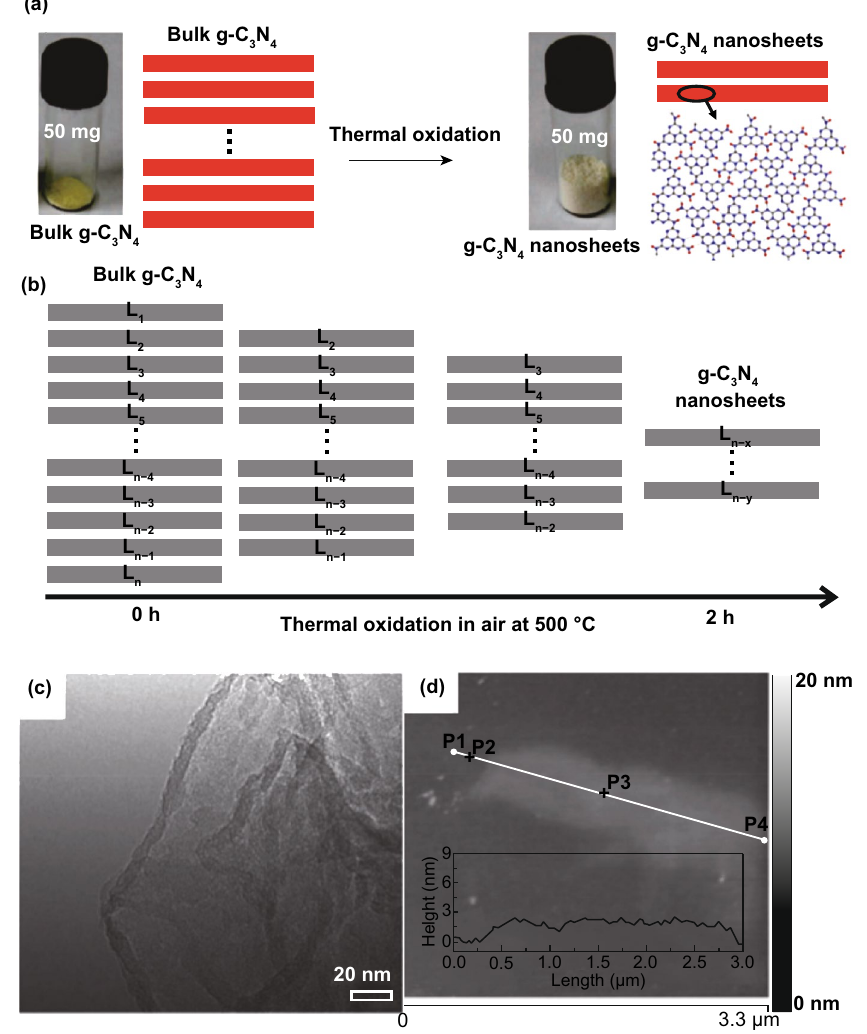
Fig. 7 a Scheme shows bulk g‑C 3 N 4 and g‑C 3 N 4 NS structures. Adapted with permission from Ref. [29]. b Scheme to fabricate g‑C 3 N 4 ‑NSs through thermal oxidation etching of bulk g‑C 3 N 4 at 500 °C in air. c TEM image, d AFM analysis of g‑C 3 N 4 ‑NSs. Adapted with permission from Ref.